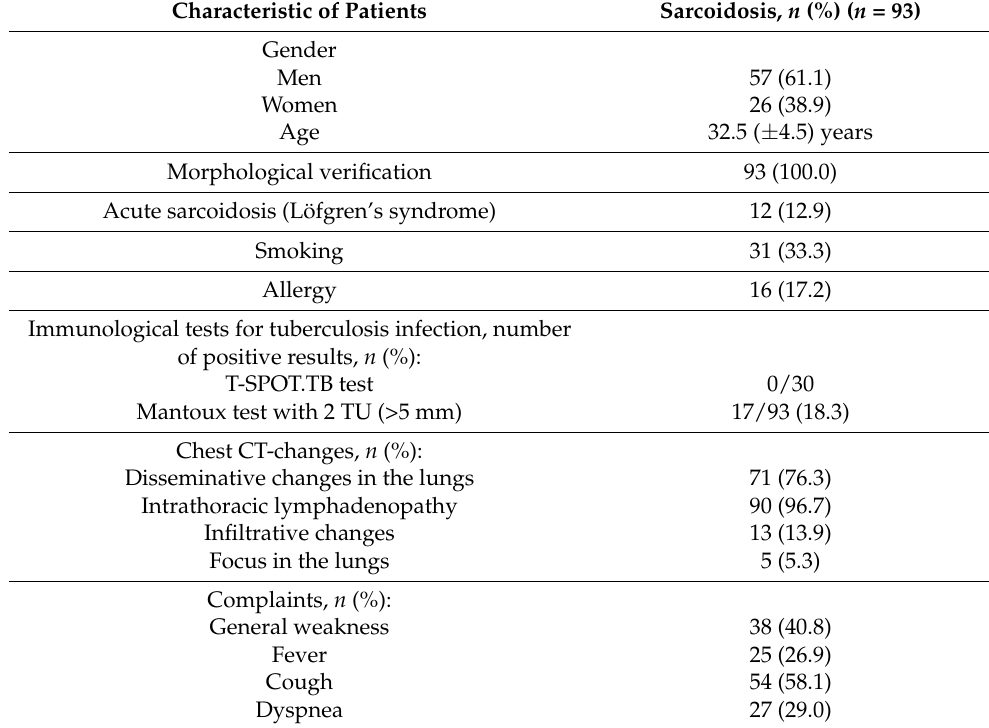
Table 1. Demographic characteristic of patients with